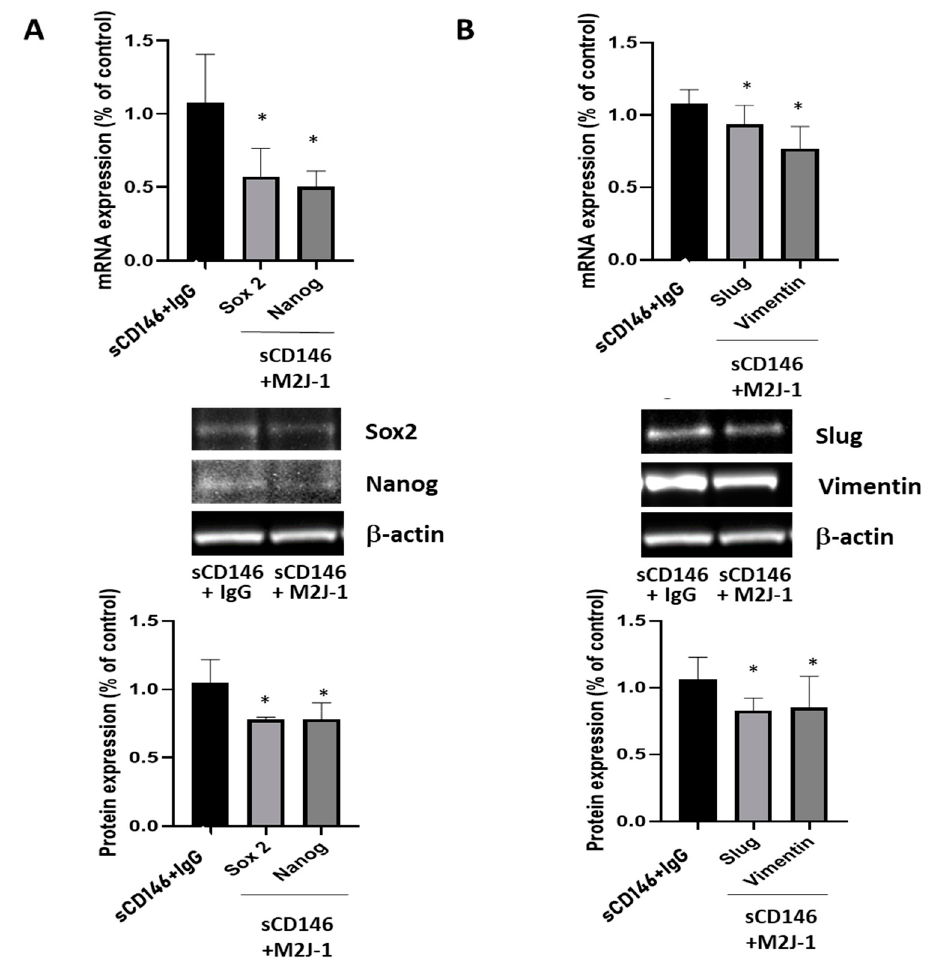
Figure 6. Effect of anti-sCD146 antibody M2J-1 in CD146-high MDA-MB-231 cells . ( A ) Effect of anti-sCD146 antibody M2J-1 50 µ g/mL for 24 h as compared to control IgG on 100 ng/mL sCD146- induced increase in CSC markers Sox2 and Nanog at the mRNA (qPCR) and protein (Western Blot) levels. Representative experiments and the average of four to five experiments are given. ( B ) Effect of anti-sCD146 antibody M2J-1 50 µ g/mL for 24 h as compared to control IgG on 100 ng/mL sCD146- induced increase in EMT markers Slug and Vimentin at the mRNA (qPCR) and protein (Western Blot) levels. Representative experiments and the average of four to five experiments are given. *: p < 0.05, sCD146 + M2J ‐ 1 vs. sCD146 + IgG.